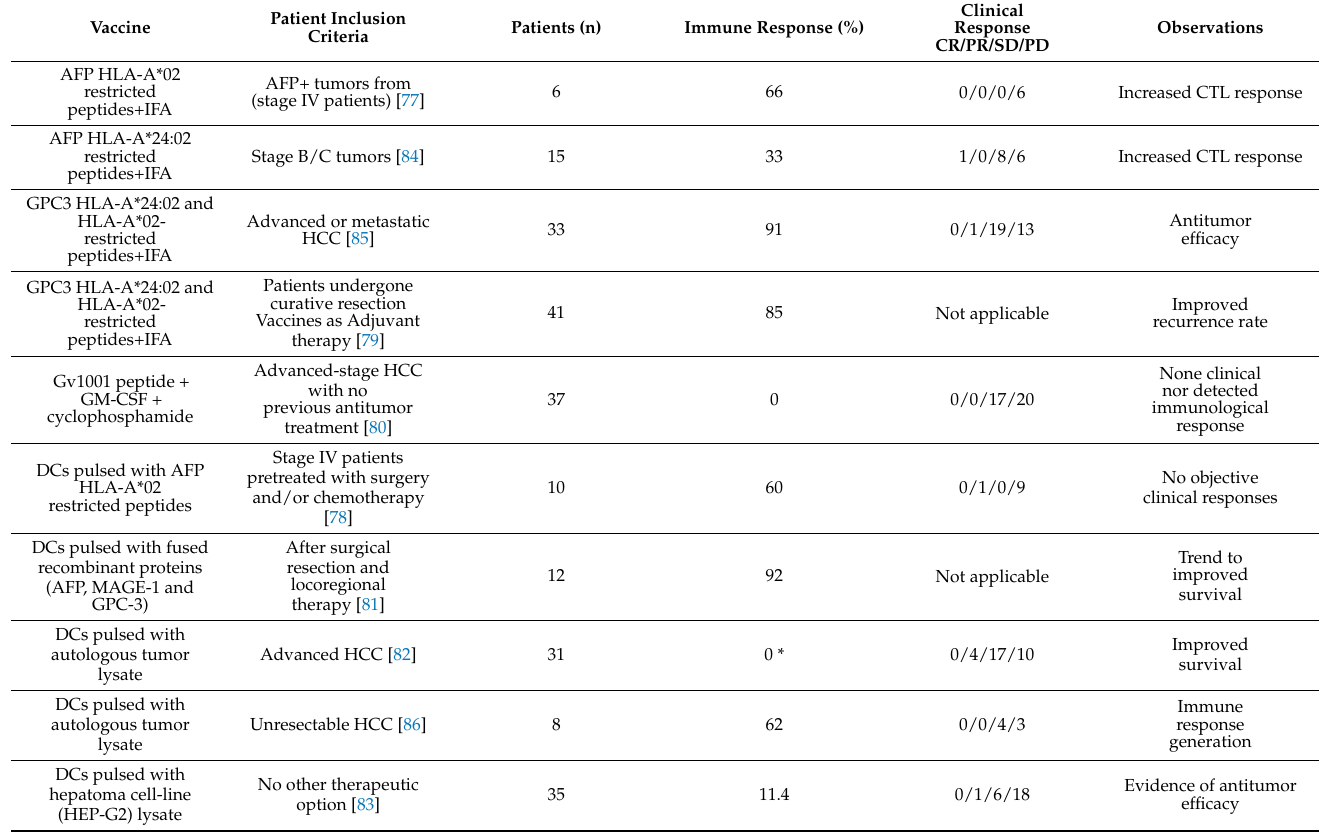
Table 2. Vaccination clinical trials in HCC with reported